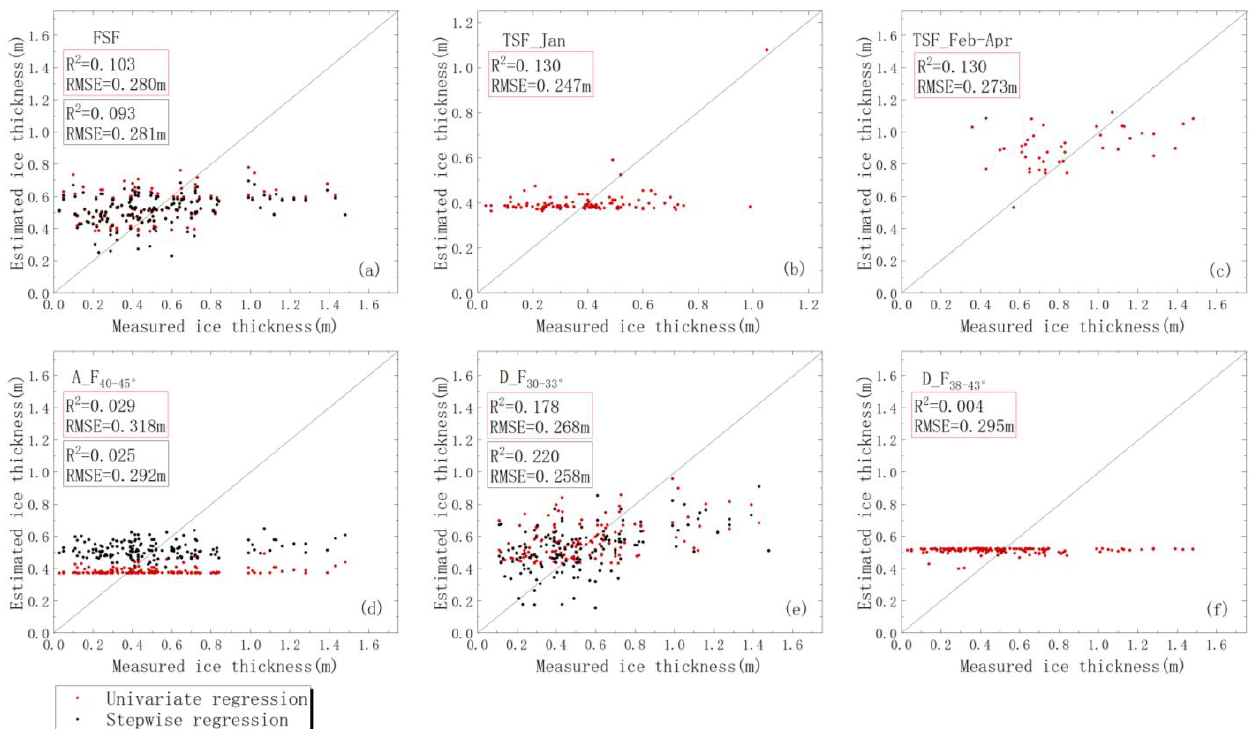
Figure 11. Stepwise regression fitting equations for the Binggou River. VH_D is the VH polarization of the descending orbit image, VV_D is the VV polarization of the descending orbit image, and Alpha_D is the descending orbit scattering angle. The orange and blue colors indicate the method with better accuracy for each scheme.